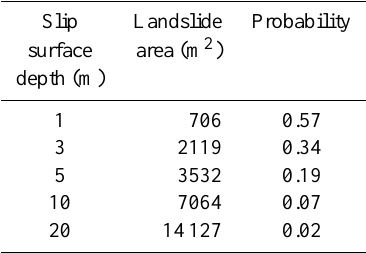
Table 3. Magnitude probability of slides according to their slip sur- face depth in the Loures municipality.